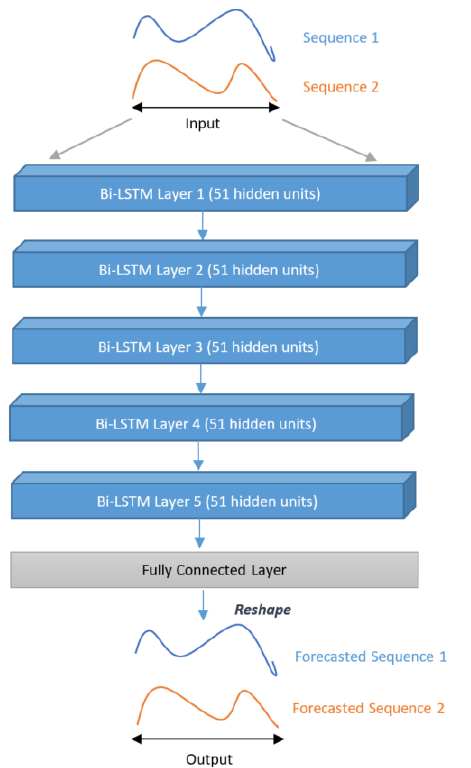
Figure 6. First Bi-LSTM architecture (Model 3) proposed in this work without considering